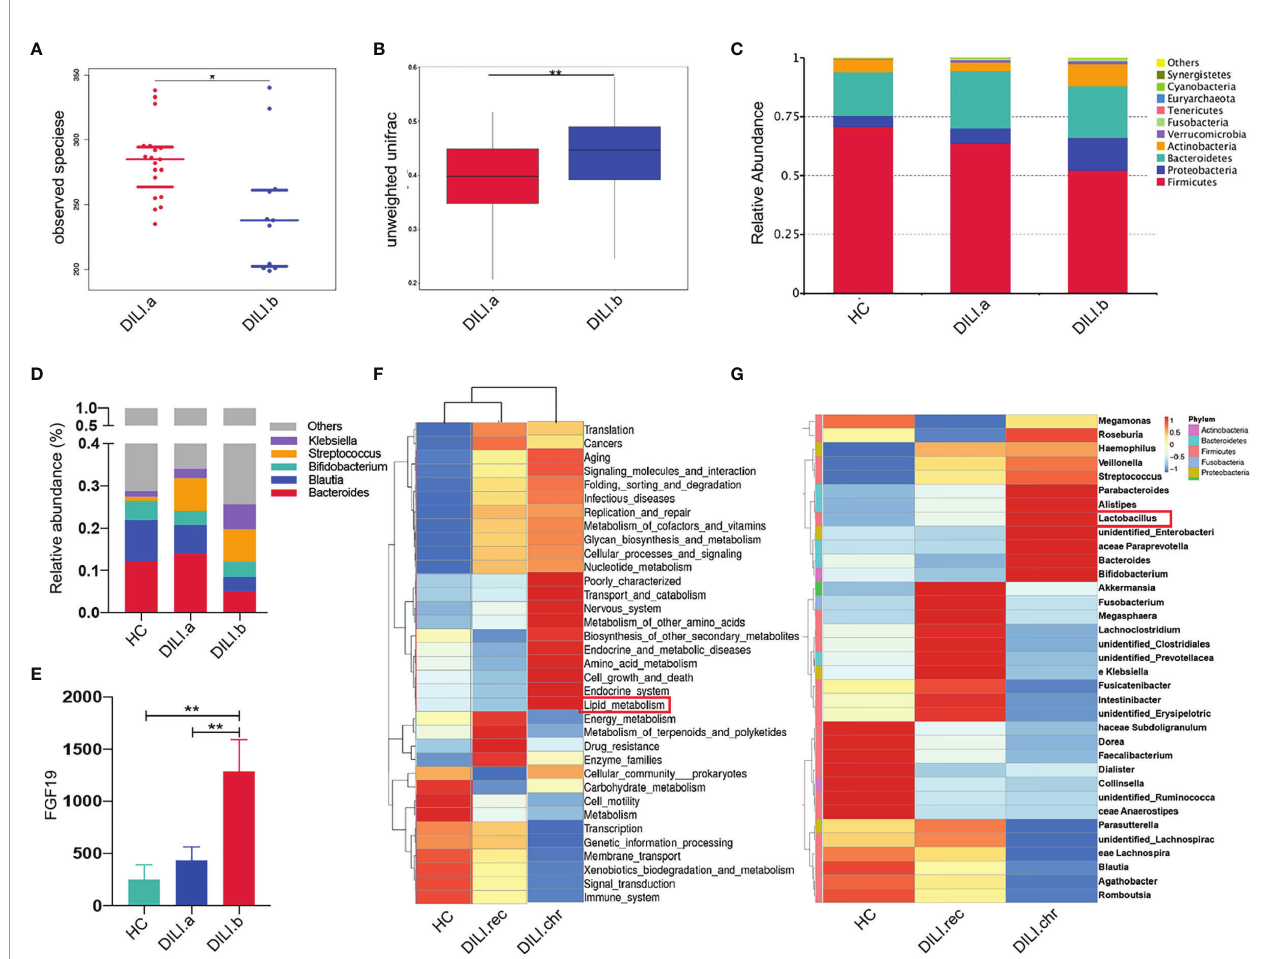
FIGURE 7 | Gut microbiota pro fi le of HCs and DILI patients. (A) The alpha diversity (observed species) index indicated the community diversity of DILI.a and DILI.b groups. (B) The beta diversity indices (unweighted wilcox) of the fecal microbiome in DILI.a and DILI.b group. (C) The relative abundance of different microbiota in HCs, DILI.a and DILI.b was shown in stacked bar chart (top 10 relevant abundance at phylum level). (D) The relative abundance of different microbiota in HCs, DILI.a and DILI.b was shown in stacked bar chart (top 5 relevant abundance at genus level). (E) Serum FGF19 levels in HC, DILI.a and DILI.b groups. (F) Cluster graph of gut microbiota function prediction using Tax4Fun (level 2). (G) Cluster graph of differential gut microbiome between HC, DILI.rec and DILI.chr at the genus level. *p < 0.05; **p <